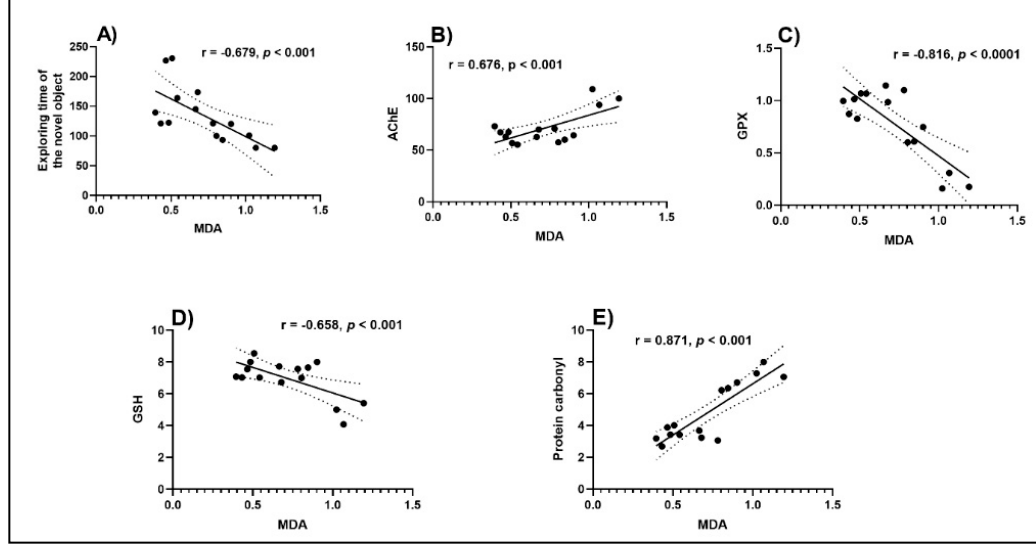
Figure 6. Correlation analyses between behavioral and biochemical parameters (Pearson’s correlation, n = 10). Data expressed are exploring time of the novel object (s), AChE (nmol/min/mg protein), GPX (U/mg protein), GSH (µg GSH/ µg protein), protein carbonyl (nmol/mg protein), and MDA (nmol/mg protein). ( A ) Exploring time of the novel object vs. MDA ( n = 10, r = − 0.679, p < 0.001); ( B ) AChE vs. MDA ( n = 10, r = 0.676, p < 0.001); ( C ) GPX vs. MDA ( n = 10, r = − 0.816, p < 0.0001); ( D ) GSH vs. MDA ( n = 10, r = − 0.658, p < 0.001) and ( E ) protein carbonyl vs. MDA ( n = 10, r = 0.871, p < 0.001).